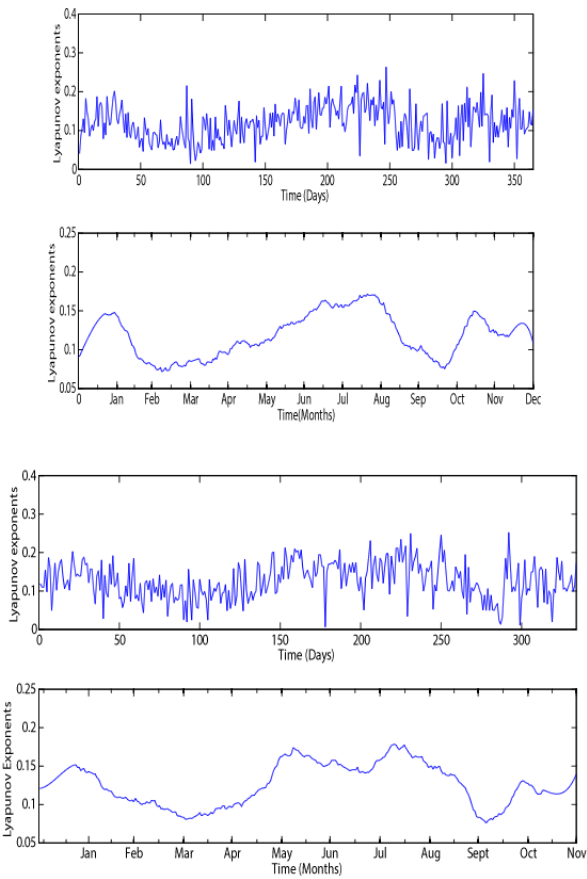
Figure 12. (a) Daily variation of Lyapunov exponents for TEC mea- sured at the Enugu station for the year 2011 showing the original data (upper panel) and the smoothed plot of daily variation of Lya- punov exponents for TEC measured at the Enugu station for the year 2011 (lower panel). (b) Daily variation of Lyapunov exponents for TEC measured at the Toro station for the year 2011 showing the original data (upper panel) and the smoothed plot of daily variation of Lyapunov exponents for TEC measured at the Toro station for the year 2011 (lower panel).